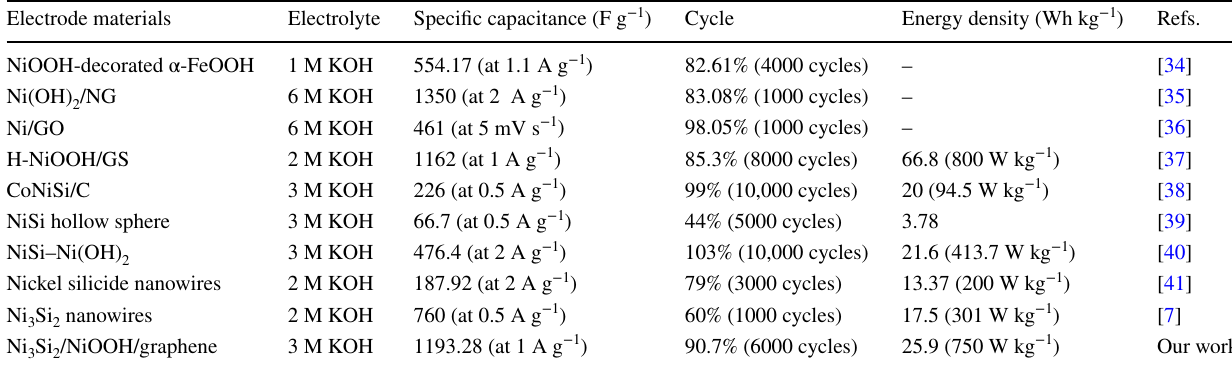
Table 1 Electrochemical properties of different nickel compounds and silicides and their composites as electrode materials Electrode